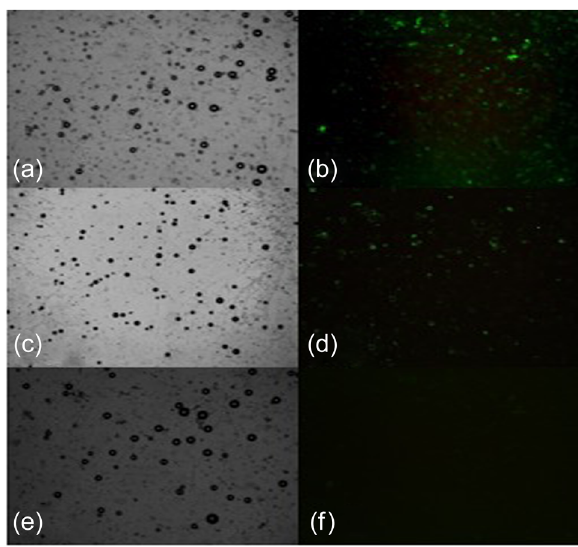
Figure 4: ICAM - expressing microbubbles observed using an inverted fl uorescence microscope ( a, c and e: white light; b, d and f: fl uorescence ) . a and b: TBCM; c and d: TBCMs with the bFGF gene; and e and f: